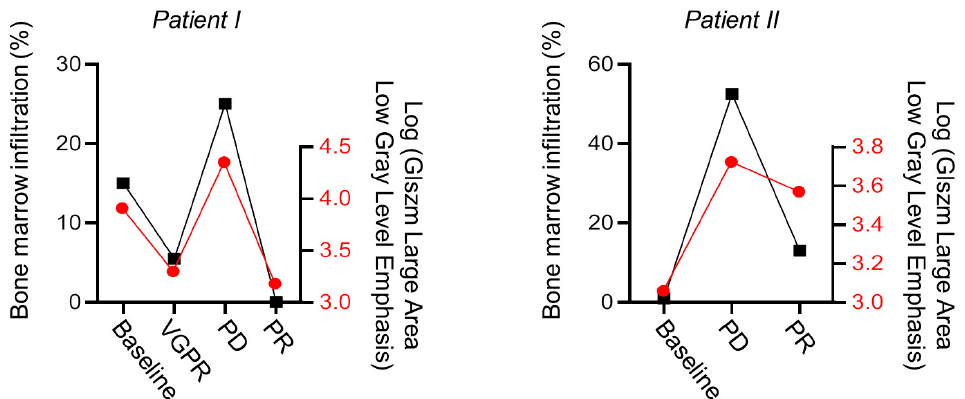
Figure 7. Longitudinal course of GLSZM large area low gray level emphasis and correlation with M-protein based response categories to anti-myeloma treatment. VGPR = very good partial response; PD = progressive disease; PR = partial response.